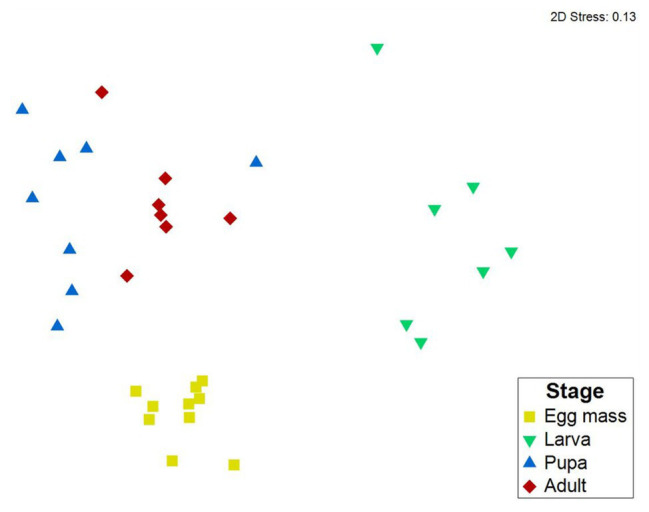
Non-metric multidimensional scaling (nMDS) analysis representing bacterial compositions in the four metamorphosis life stages of C. transvaalensis. Stress = 0.13 (Bray–Curtis), n = 32 samples. Significant differences were found between the microbiota compositions of all four life stages (ANOSIM: R = 0.874, p < 0.001). Egg masses: yellow; larvae: green; pupae: blue; adults: red.